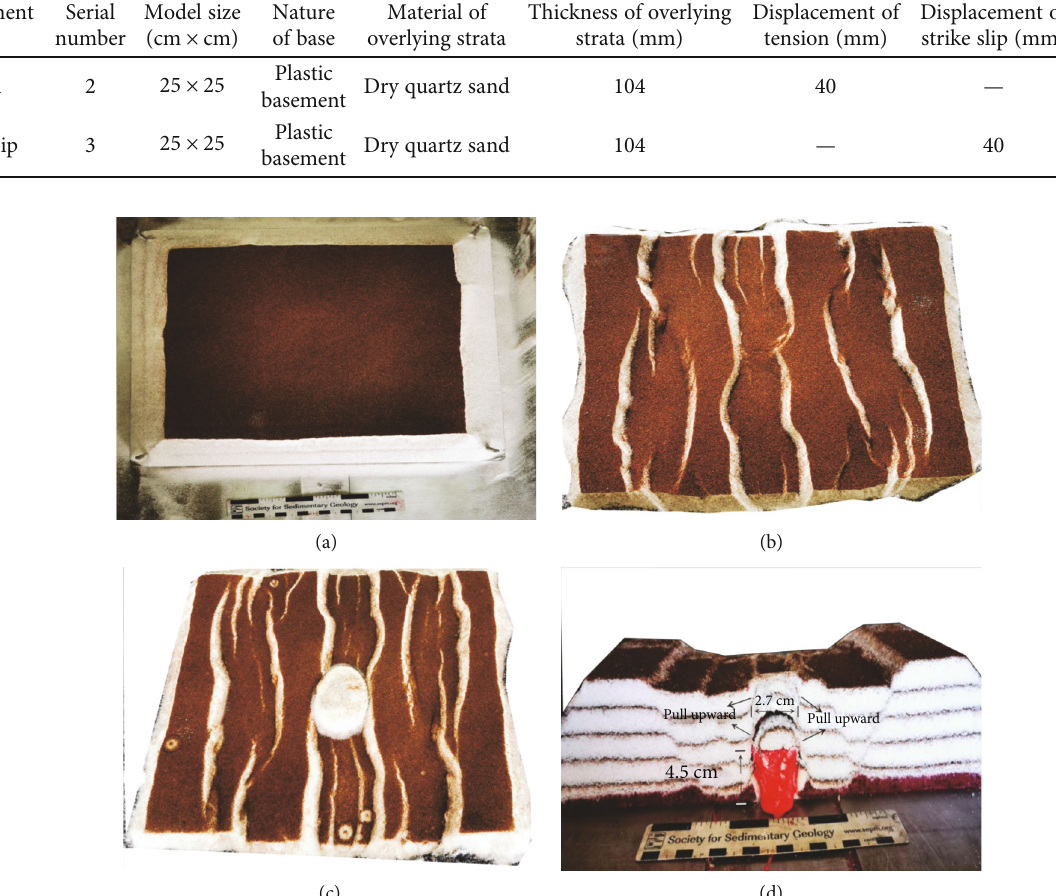
Figure 6: Experiment 2-1 records the formation simulation of mud diapir under the tension background. (a) In the early stage of tension, there are a few fractures on the surface of the model. (b) In the late stage of tension, there are a lot of symmetrical fractures on the surface of the model. (c) In the crosscutting diagram of the outer edge of the model, it can be seen that there are mounds in the middle of the model and a lot of symmetrical fractures on the side. (d) In the crosscutting diagram of the center of the model, the fl uid fl ows up and punctures the stratum, and the stratum is pulled